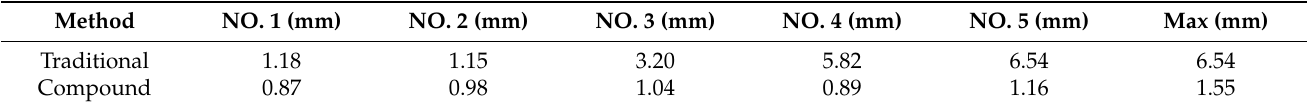
( d ) Figure 14. The position and speed in the acceleration and deceleration. ( a ) Position at acc-time; ( b ) position at dec-time; ( c ) speed at acc-time; ( d ) speed at dec-time. Finally, the sensorless experiment under the load was carried out. The load was ap- plied by the pulley, as shown in Figure 15, and the load thrust was 30 N. When the WS- PMLM starts, the heavy object falls on the ground due to the long string. It has no load at this time. After the motor runs, the rope is tightened and the heavy object is lifted. This is the moment of sudden load. The phase current was monitored to characterize the change before and after loading. The speed command was 0.582 m/s. The experimental waveform is shown in Figure 16.